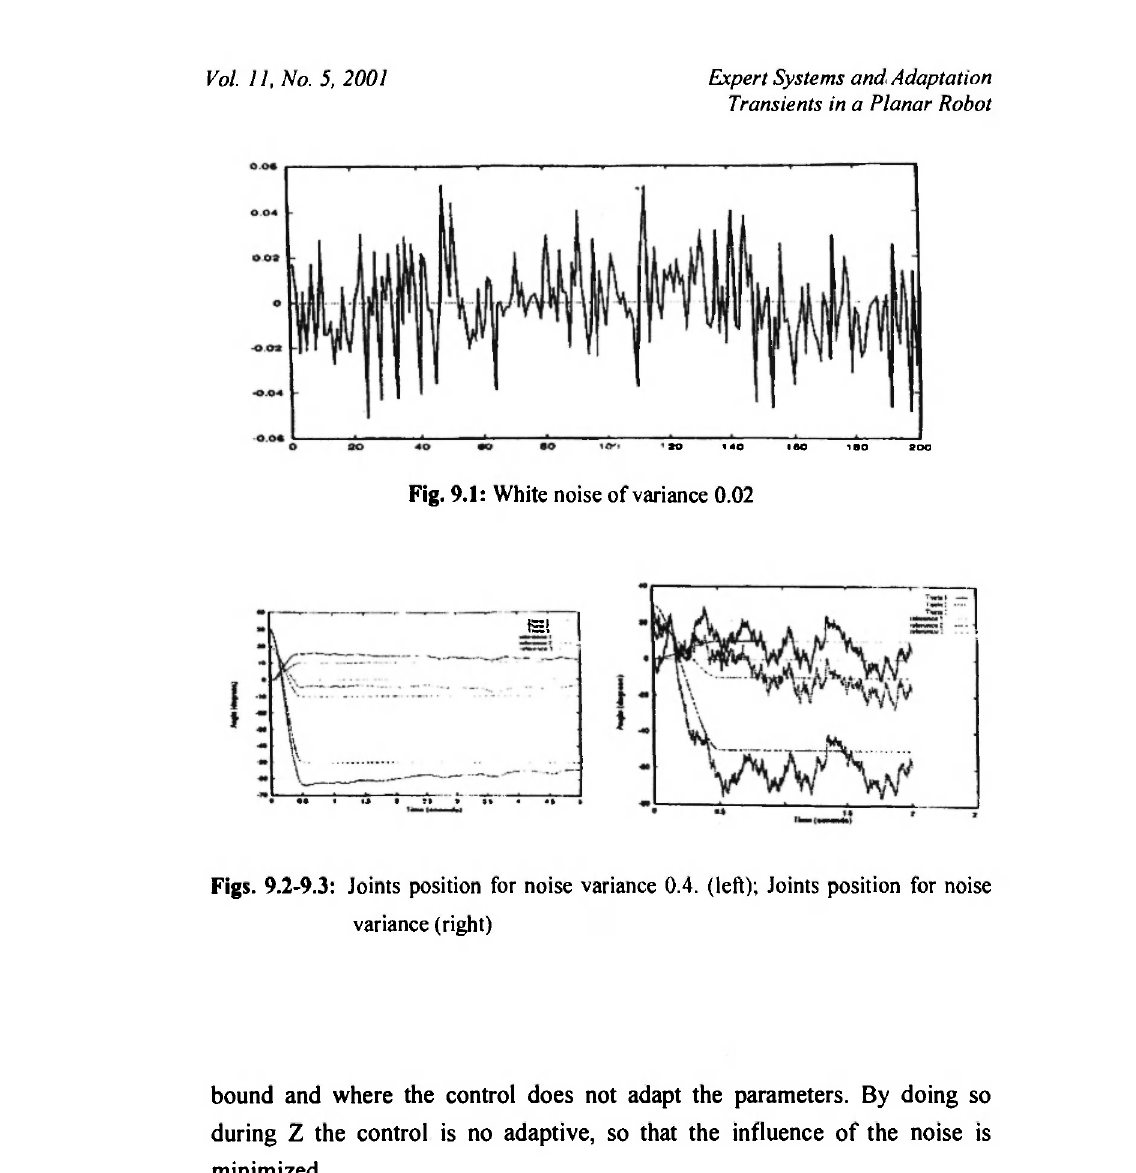
Figs. 9.2-9.3: Joints position for noise variance 0.4. (left); Joints position for noise variance